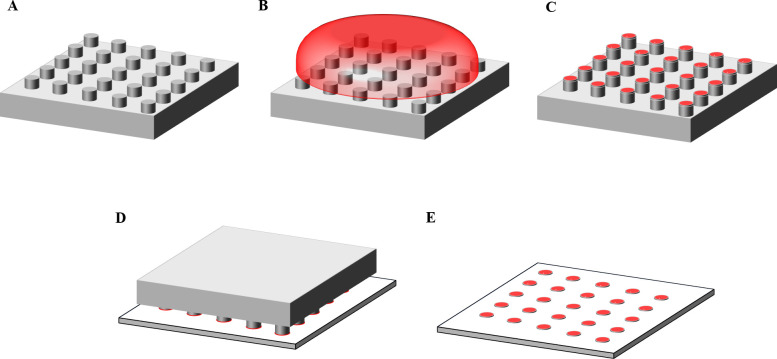
Schematic of steps of microcontact printing.(A) PDMS stamp with an array of posts as a pattern, (B) Incubation of the protein ink on the PDMS stamp, (C) Adsorption of the protein ink on the stamp, (D) Bringing the stamp onto contact with the glass coverslip, and (E) Transfer of the ink to the glass coverslip.